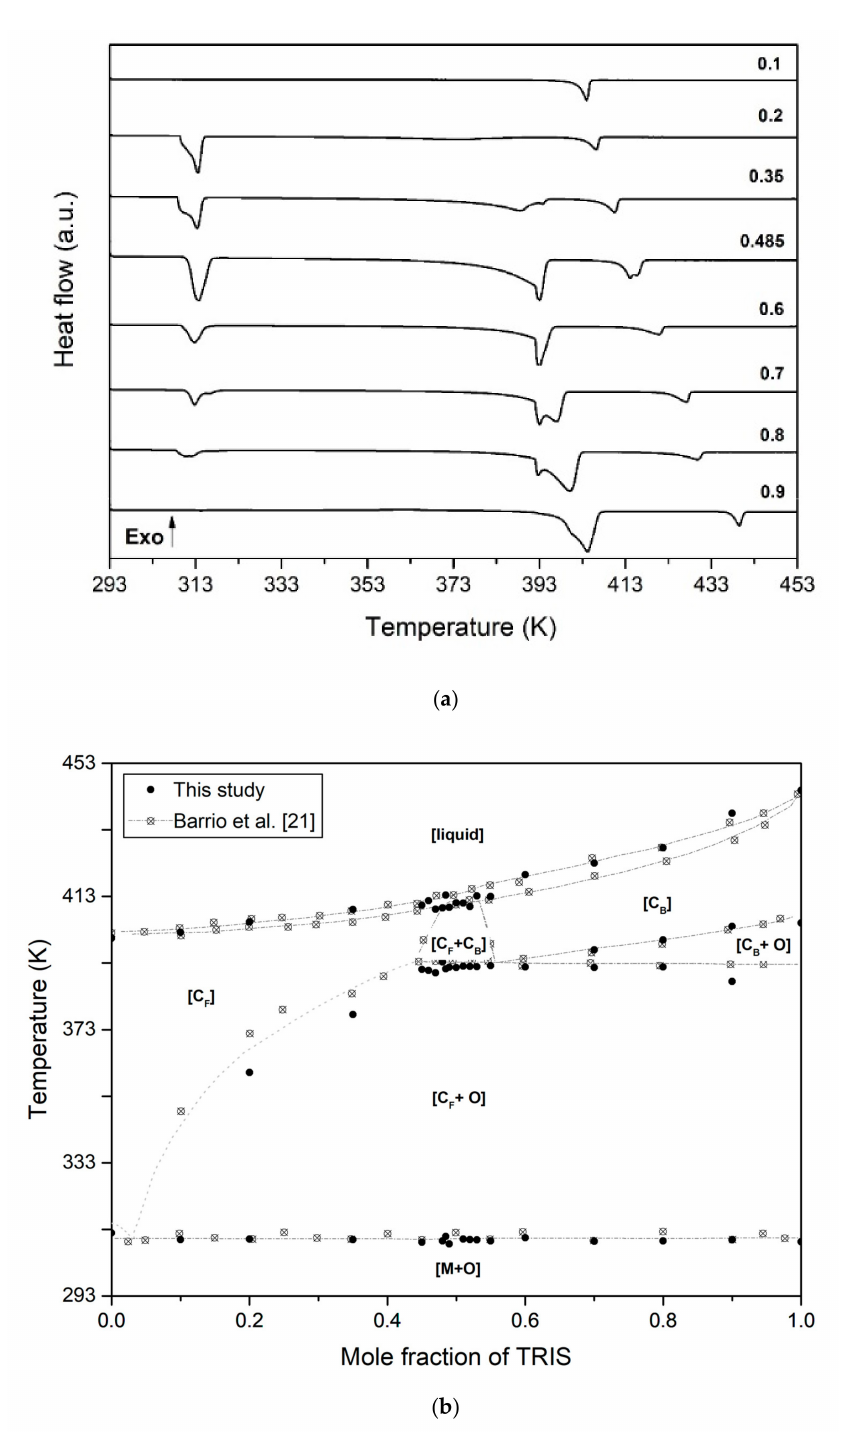
Figure 3. ( a ) DSC thermograms for eight selected compositions and ( b ) phase diagram of the NPG-TRIS system proposed by Barrio et al. [22] (discontinuous lines), with the experimental points of these authors and those obtained in this